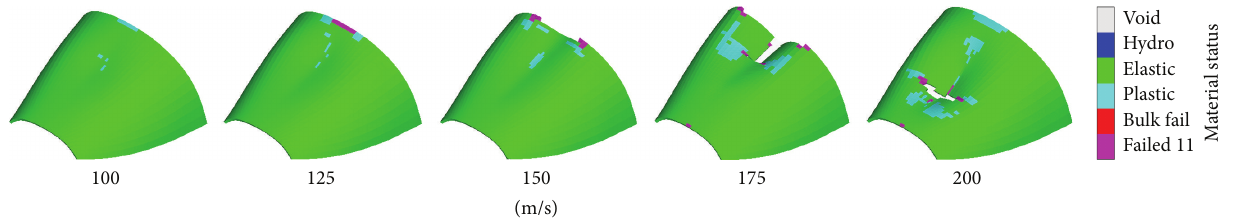
Figure 16: Deformation modes of windshield at different impact velocities.